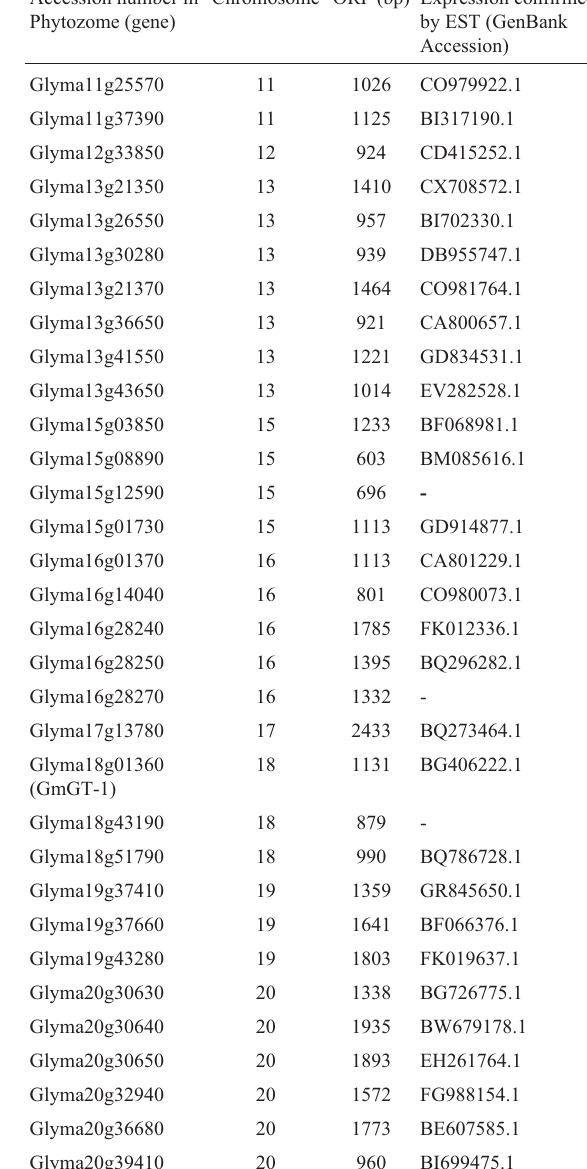
Table 2 - Annotation of soybean trihelix-GT